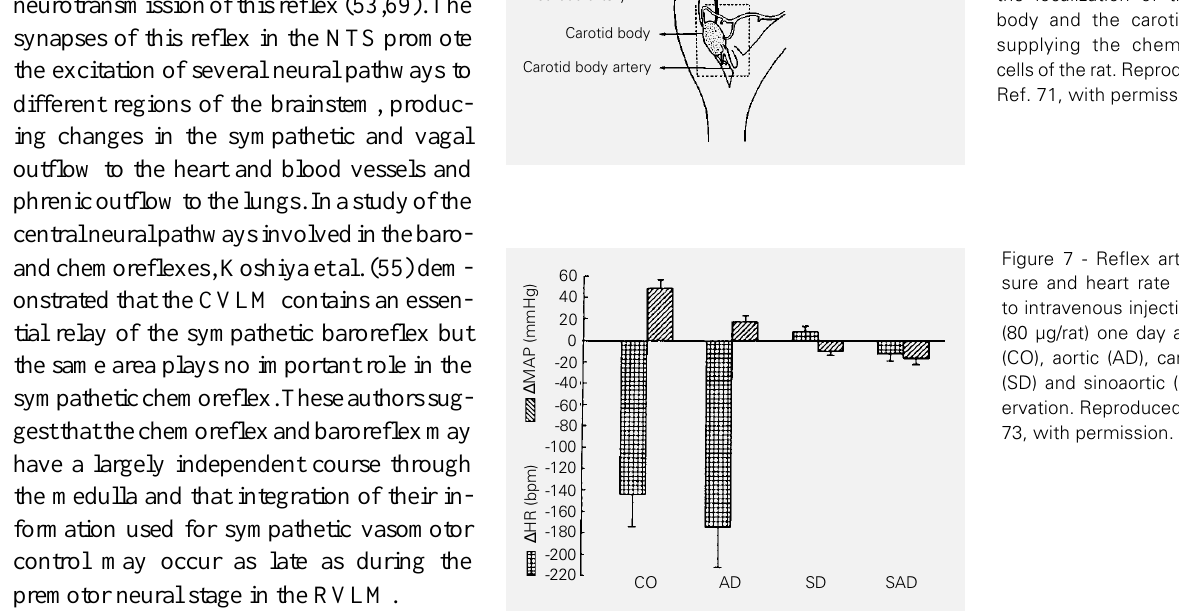
Figure 6 - Diagram illustrating the localization of the carotid body and the carotid arteries supplying the chemoreceptor cells of the rat. Reproduced from Ref. 71, with permission.